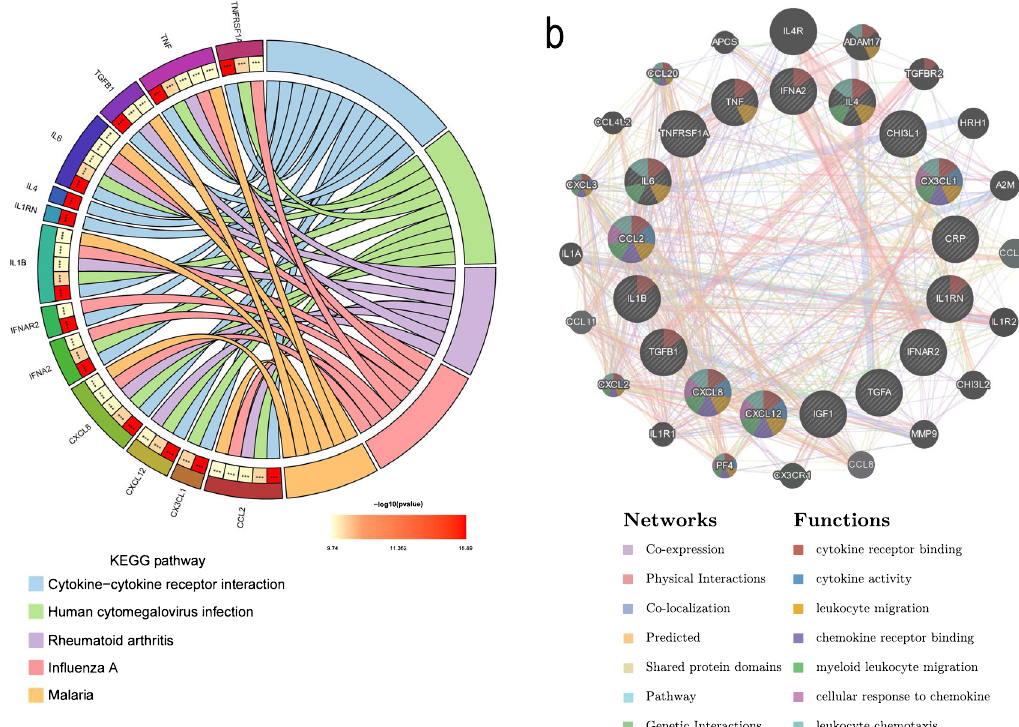
Fig. 5 The KEGG pathway enrichment analysis and PPI network construction analysis of in fl ammatory markers. The KEGG pathway enrichment analysis showed that the in fl ammatory markers related to PD were mainly involved in cytokine – cytokine receptor interactions, human cytomegalovirus infection, rheumatoid arthritis, in fl uenza A and the malaria pathway ( a ). The PPI analysis revealed that the major functions were involved in cytokine receptor binding, cytokine activity, leucocyte migration, chemokine receptor binding, myeloid leucocyte migration, cellular response to chemokine and leucocyte chemotaxis ( b